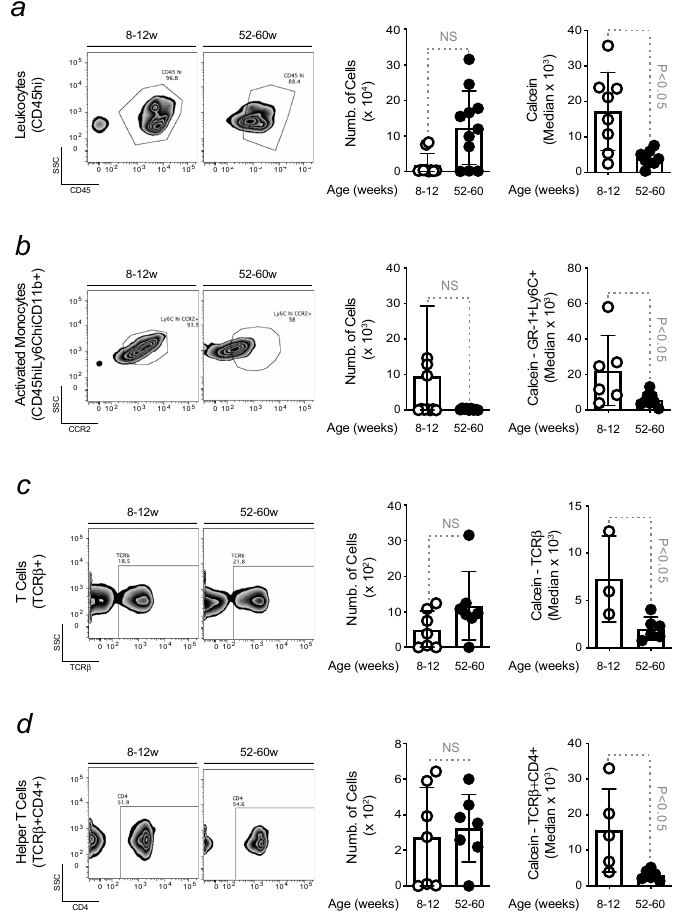
Figure 4. Increased level of intracellular Fe in peripheral blood leukocytes during aging. Gating strategy of ( a ) freshly isolated peripheral blood leukocytes (CD45hi), and subsets within contour plots representing ( b ) activated monocytes (Ly6ChiCCR2+), ( c ) T cells (TCR β +), and ( d ) helper T cells (CD4+) from young and old mice. Histogram represents the respective number of cells and the calcein median fluorescence intensity for ( a – d ). The results were expressed as mean ± SD ( n = 5–11 mice per group). Statistical analysis was defined by applying non-parametric Mann–Whitney